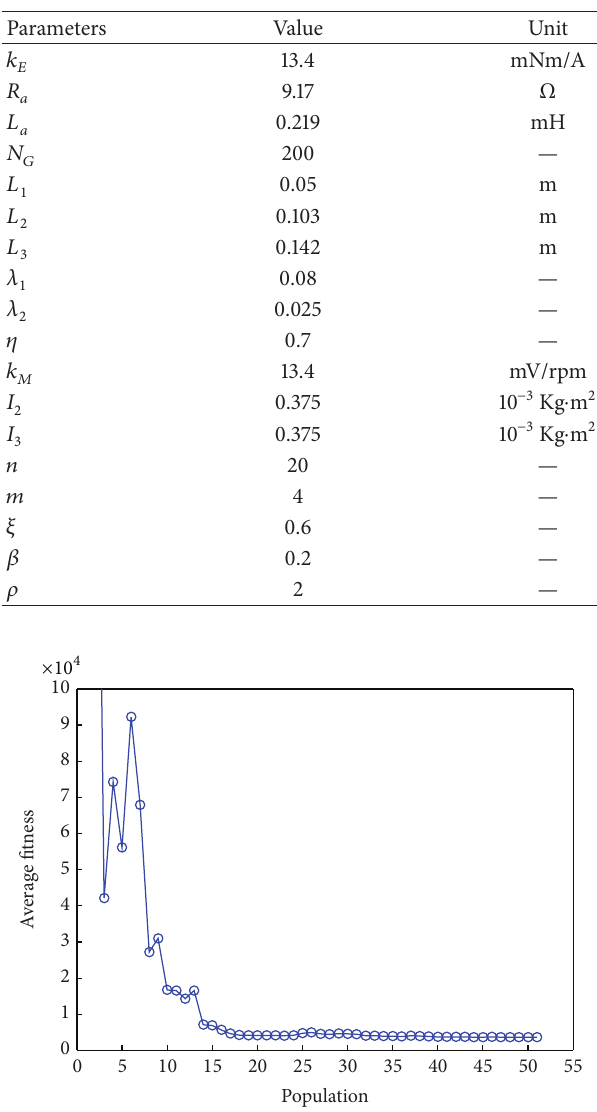
Figure 5: Variation of mean